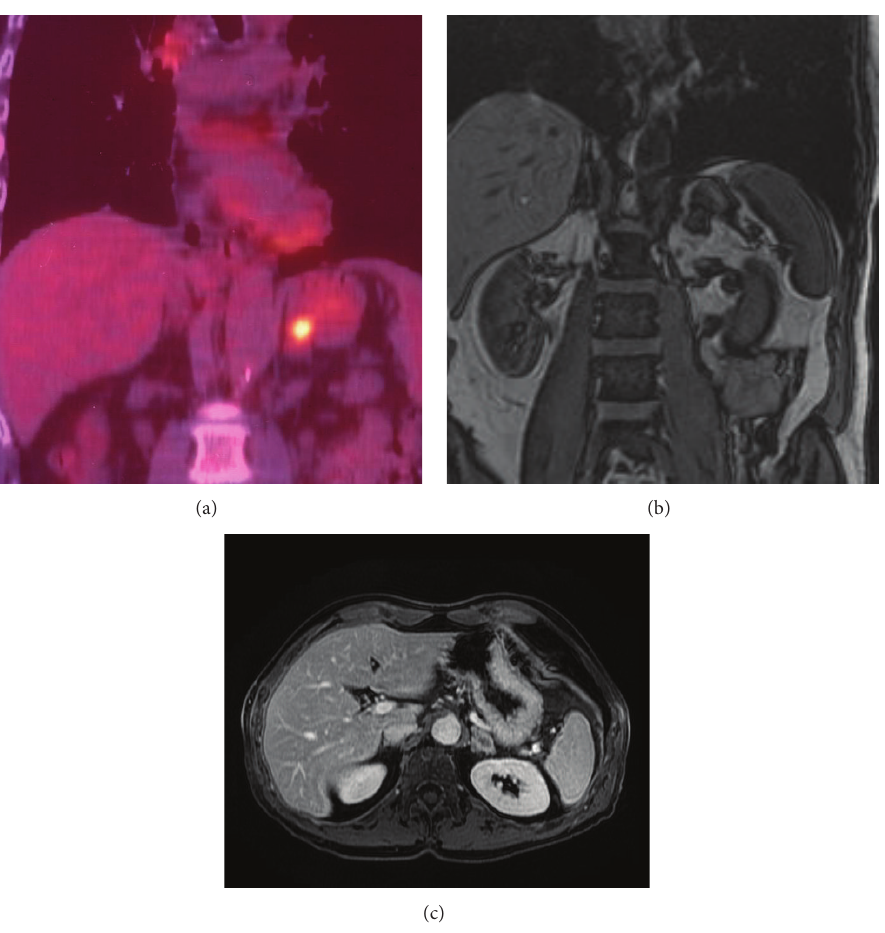
Figure 7: Images for a 70-year-old man with NSCLC (adenocarcinoma). (a) PET/CT showed intense 18 F-FDG uptake by an adrenal metastasis. (b) Coronal out-of-phase image and (c) axial MR image with contrast medium confirming adrenal